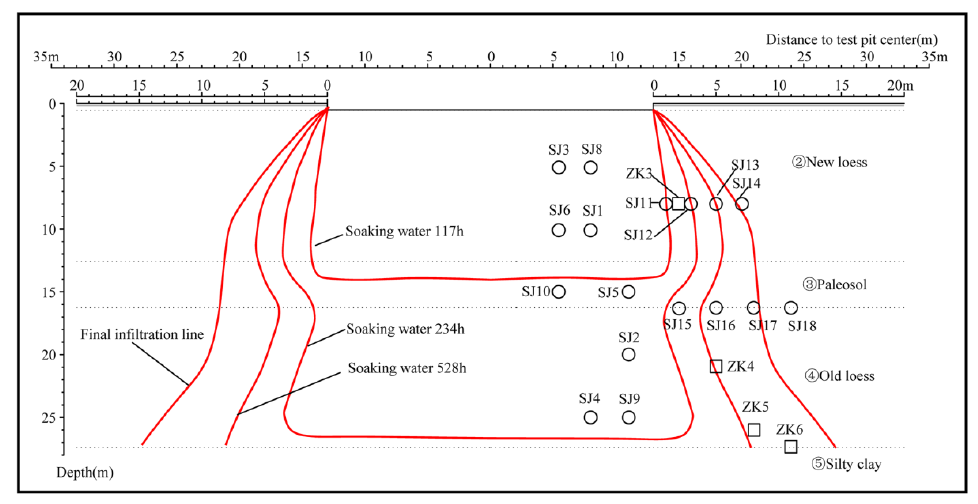
Figure 14. Immersion line change with time.